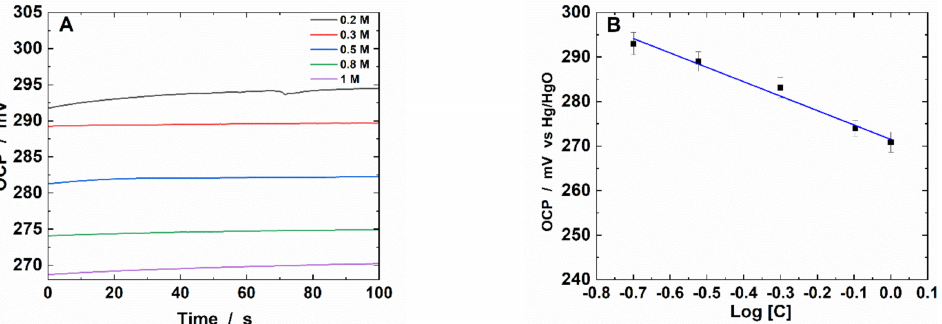
Figure 11. ( A ) OCP tests at different sulfate concentrations; ( B ) calibration line obtained from OCP